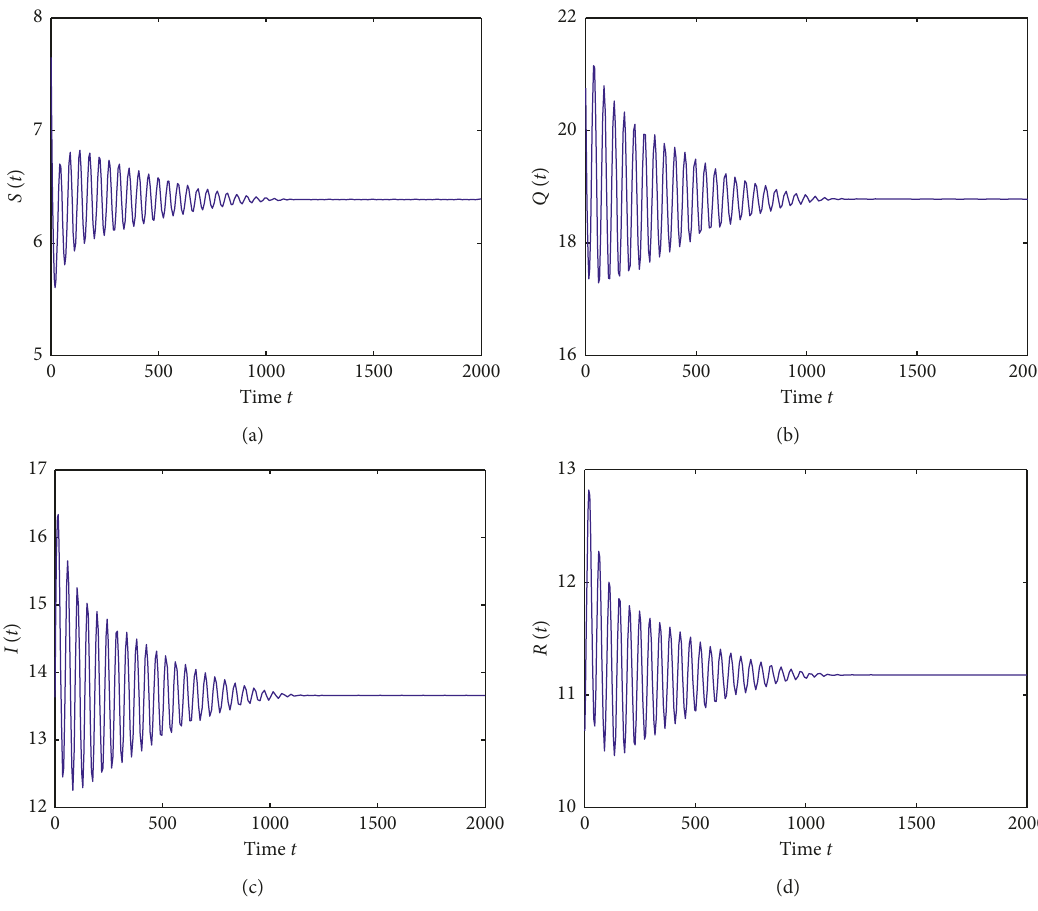
Figure 2: Waveform plots of system (65) with τ